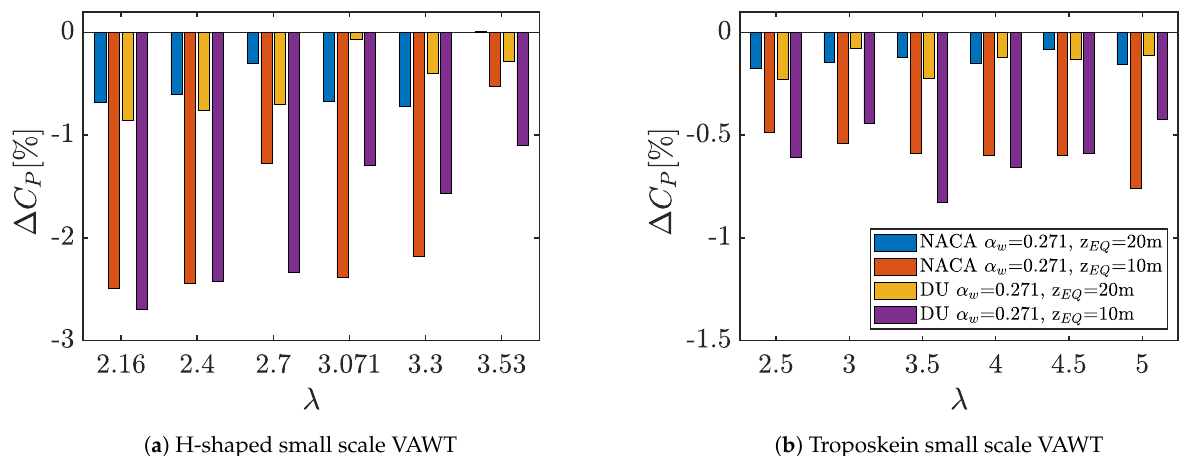
Figure 12. Sensitivity analysis to wind shear coefficient α w and hub height z EQ . Power coefficient reduction ∆ C P is referred to the condition without wind shear α w =